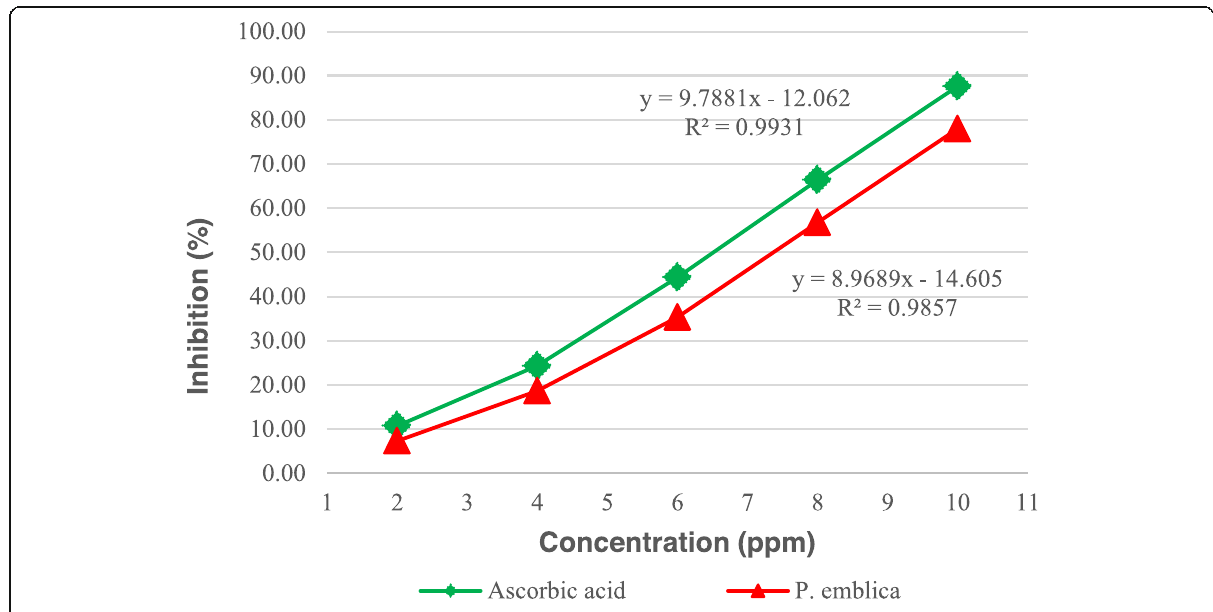
Fig. 1 A concentration relationship curve with inhibition of the vitamin C and the fraction of the ethyl acetate of the Malaka